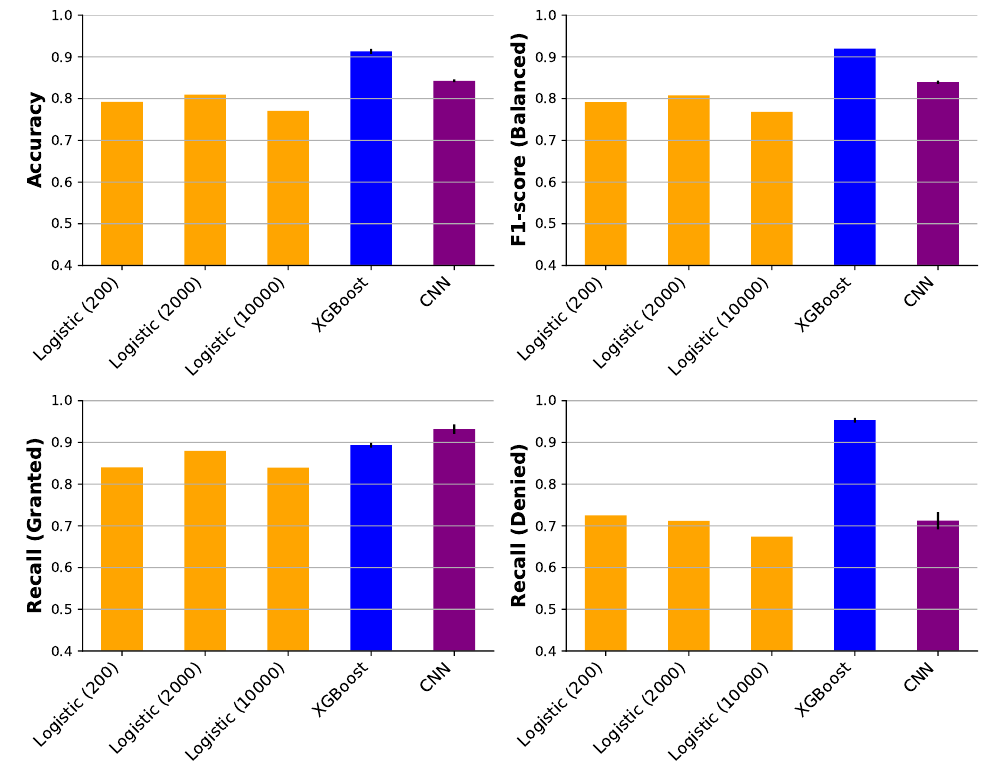
Figure 4. Results of predicting grant or denial in written decisions on petitions filed after 1 January 2019, for the model trained on written decisions for petitions filed up to 31 December 2017. The metrics are averaged over 5 runs for CNN-Attention and 3 runs for XGBoost (error bars indicate standard deviation). The graph at the upper left shows accuracy, calculated by dividing the number of correct predictions by the test set size. The graph at the upper right shows the sensitivity and speci- ficity using the balanced F1 -score, which is the harmonic mean of precision (true positives divided by all positive predictions) and recall (true positive rate, i.e., sensitivity), accounting for the imbalance between positive and negative classes. To illustrate the impact of the class imbalance rate, the graphs at the bottom left and right show the recall for the granted and denied classes separately. Which indicate that the CNN model is less sensitive to denials than